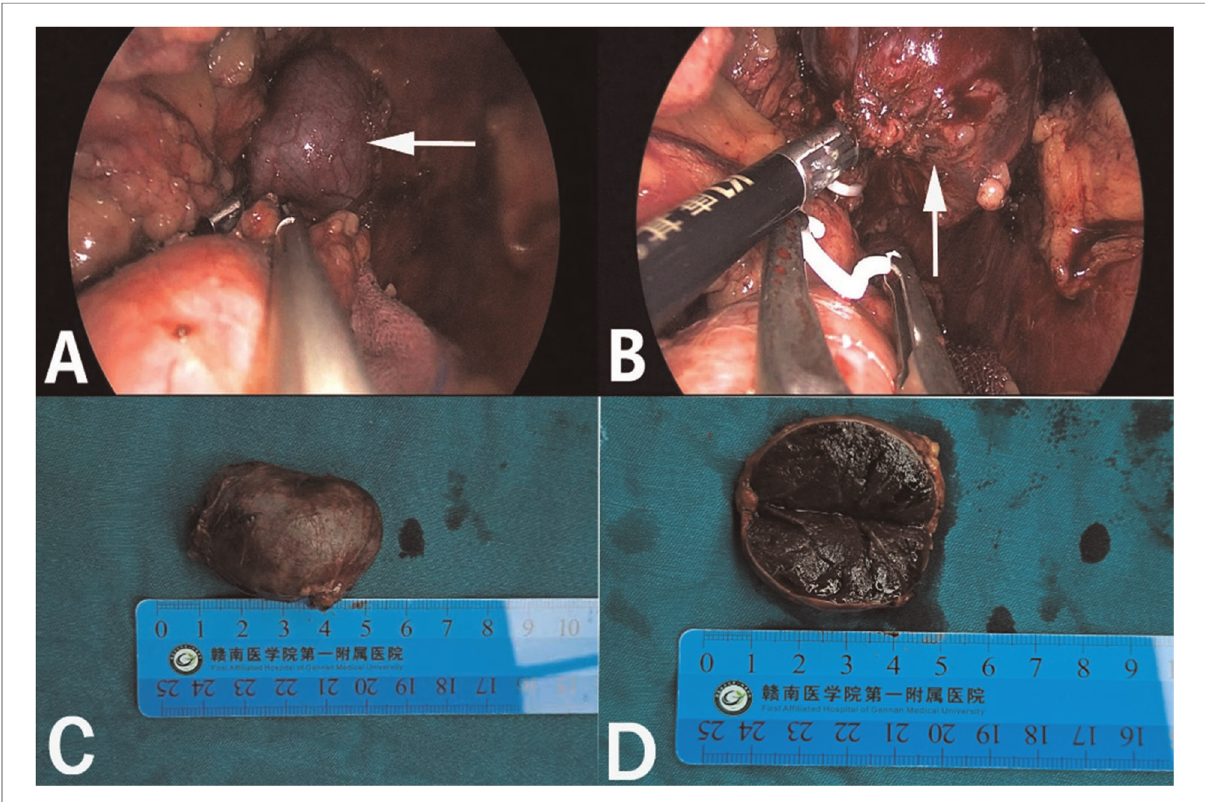
FIGURE 2 Retroperitoneal laparoscopic resection of the mass (arrow). The mass is located in the left suprarenal region, and the boundaries between the dorsal side of the mass were clear, loose and non-adhered ( A ), the ventral side adhered closely to the peritoneum ( B ). Gross appearance. The mass was dark red, and the surface envelope of the mass was intact ( C ), and had a similar splenic structure with multiple sinusoid tissues ( D